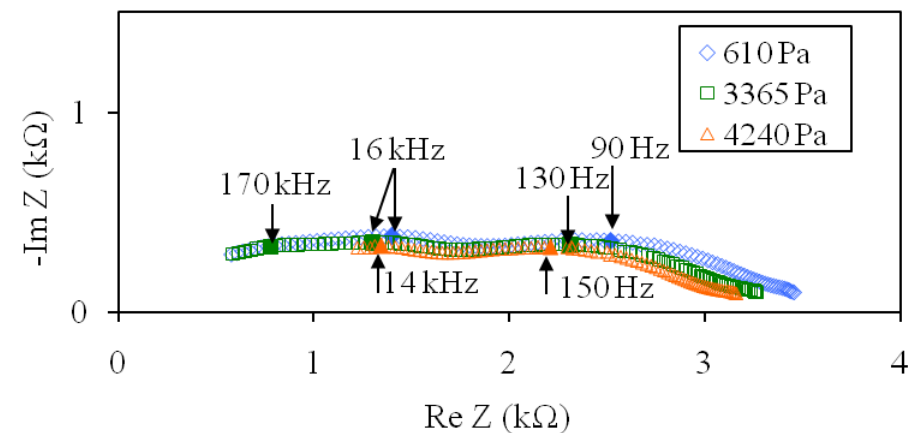
Figure 10. Impedance spectra of the cell p H 2 O / , Pt / SZY / Pt, p H 2 O // at 750 ◦ C in air at p H 2 O / = 40 Pa and p H 2 O // = 4240, 3365 and 610 Pa.